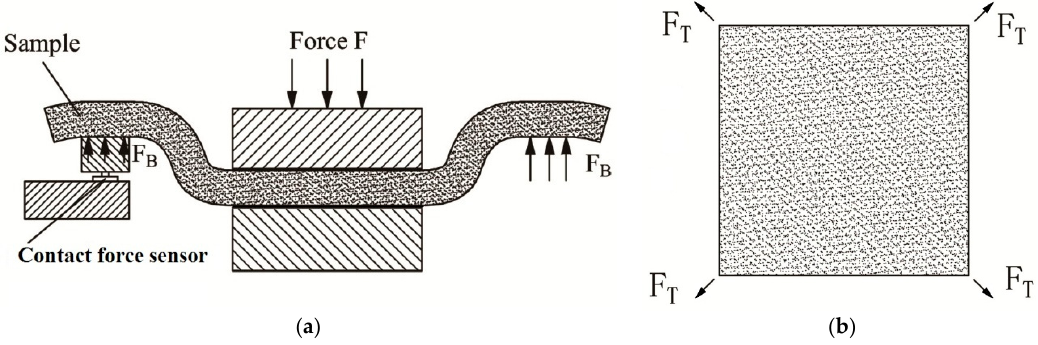
Figure 4. Bending and twisting performance measurement: ( a ) bending; ( b ) twisting.